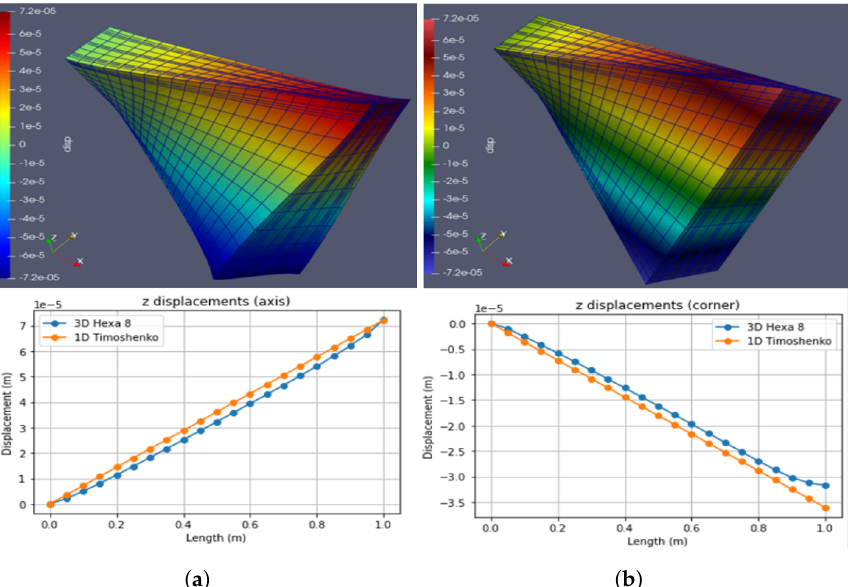
Figure 10. Case 3: Torsional load at the end of the beam (2800 N.m). ( a ) Hexa8. ( b ) Timoshenko. (Note: e − n indicates 10 − n ).